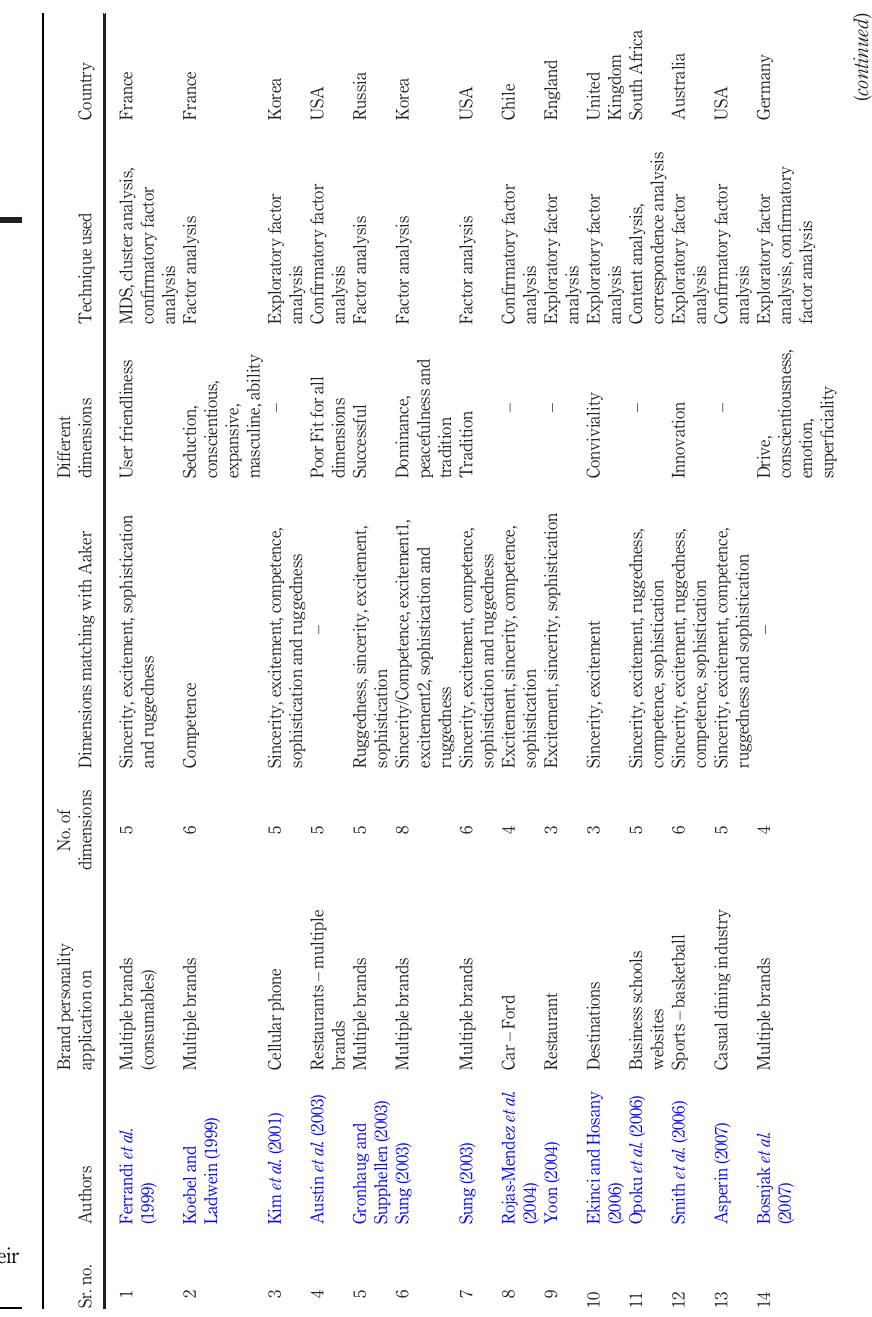
Table IV. Efforts on brand personality and their